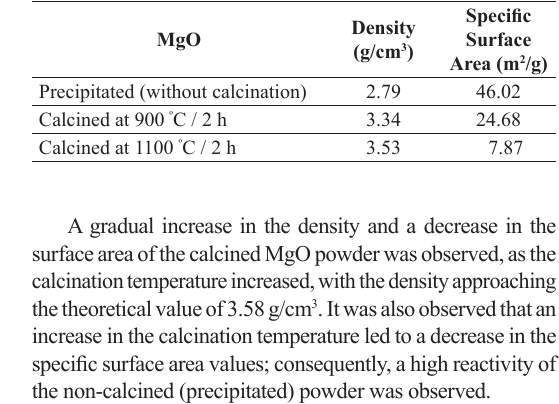
Table 1. Density and specific surface area of MgO powders precipitated (without calcination) and calcined at different